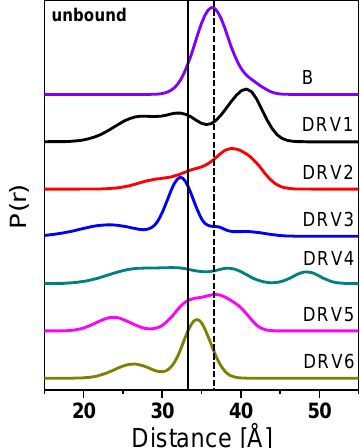
Figure 3. Double electron-electron resonance (DEER) distance probability profiles for unbound HIV-1 PR PI-naïve subtype B, DRV1, DRV2, DRV3, DRV4, DRV5, and DRV6, from top to the bottom. Profiles are area normalized to 100% probability distribution, P(r), and are vertically offset for clarity. Dashed line at 36 Å represents the purported distance observed for HIV-1PR semi-open population, whereas the solid line at 33 Å signifies the distance observed for the HIV-1PR closed population.